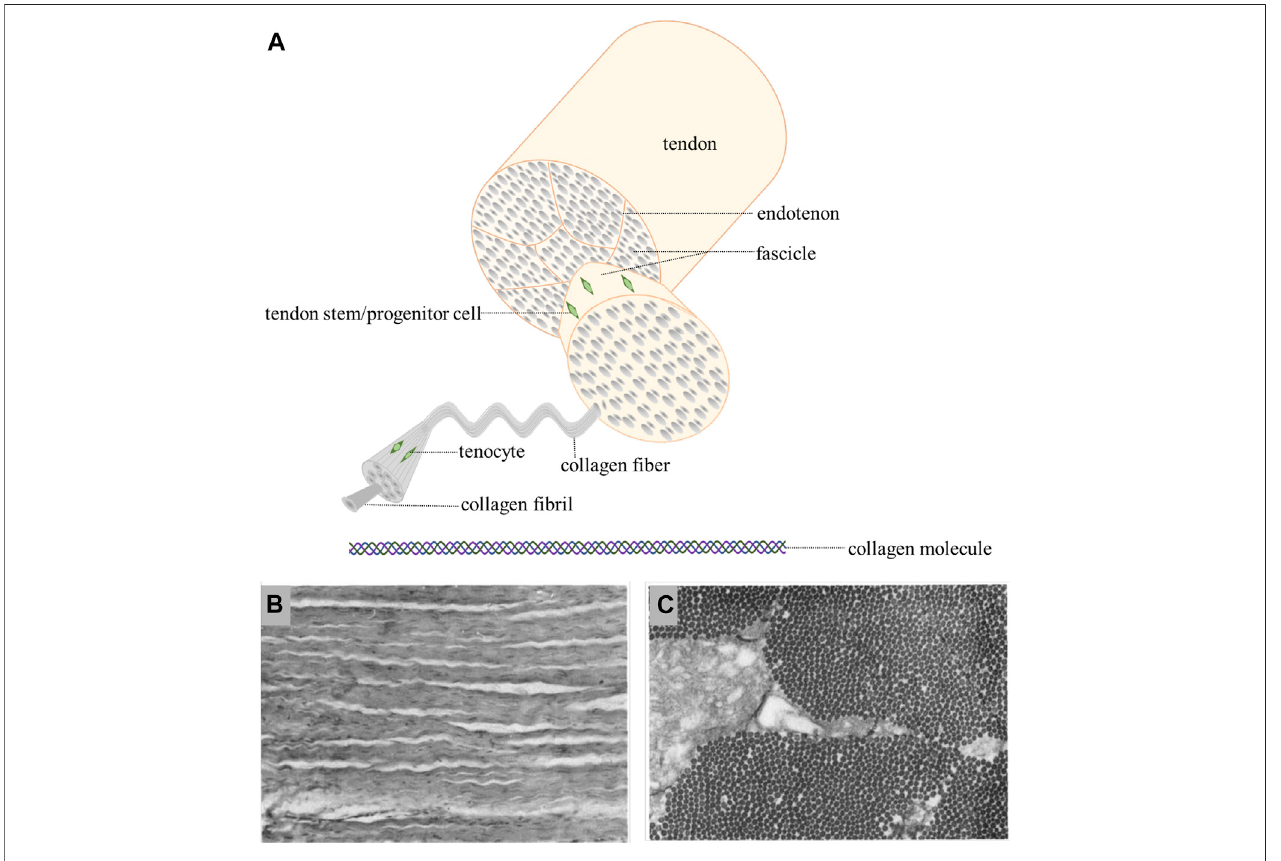
FIGURE 1 | (A) : hierarchical structure of tendon/ligament [Adapted from No et al. (2020)] (Created with BioRender.com). (B) : longitudinal section show crimped and uniformly oriented fi bers (Strocchi et al., 1991). (C) : in transverse section, the same size collagen fi brils are seen (Strocchi et al., 1991).